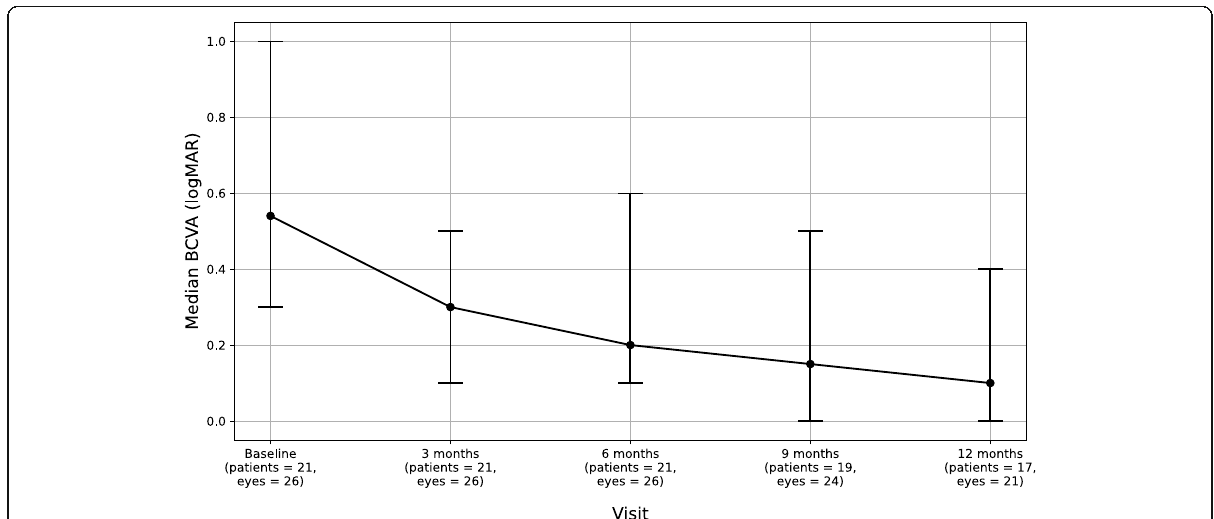
Fig. 1 Median Best-Corrected Visual Acuity (BCVA) over 12 Months. A decrease in logMAR corresponds to an improvement in visual acuity. Two patients were lost to follow-after the 6 months visit, resulting in 19 patients (24 eyes) at the 9 months mark. At the 12 month mark, no additional patients were lost to follow-up but 2 patients (1 unilateral, 1 bilateral, 3 eyes) did not have their visual acuity recorded in the medical records at that